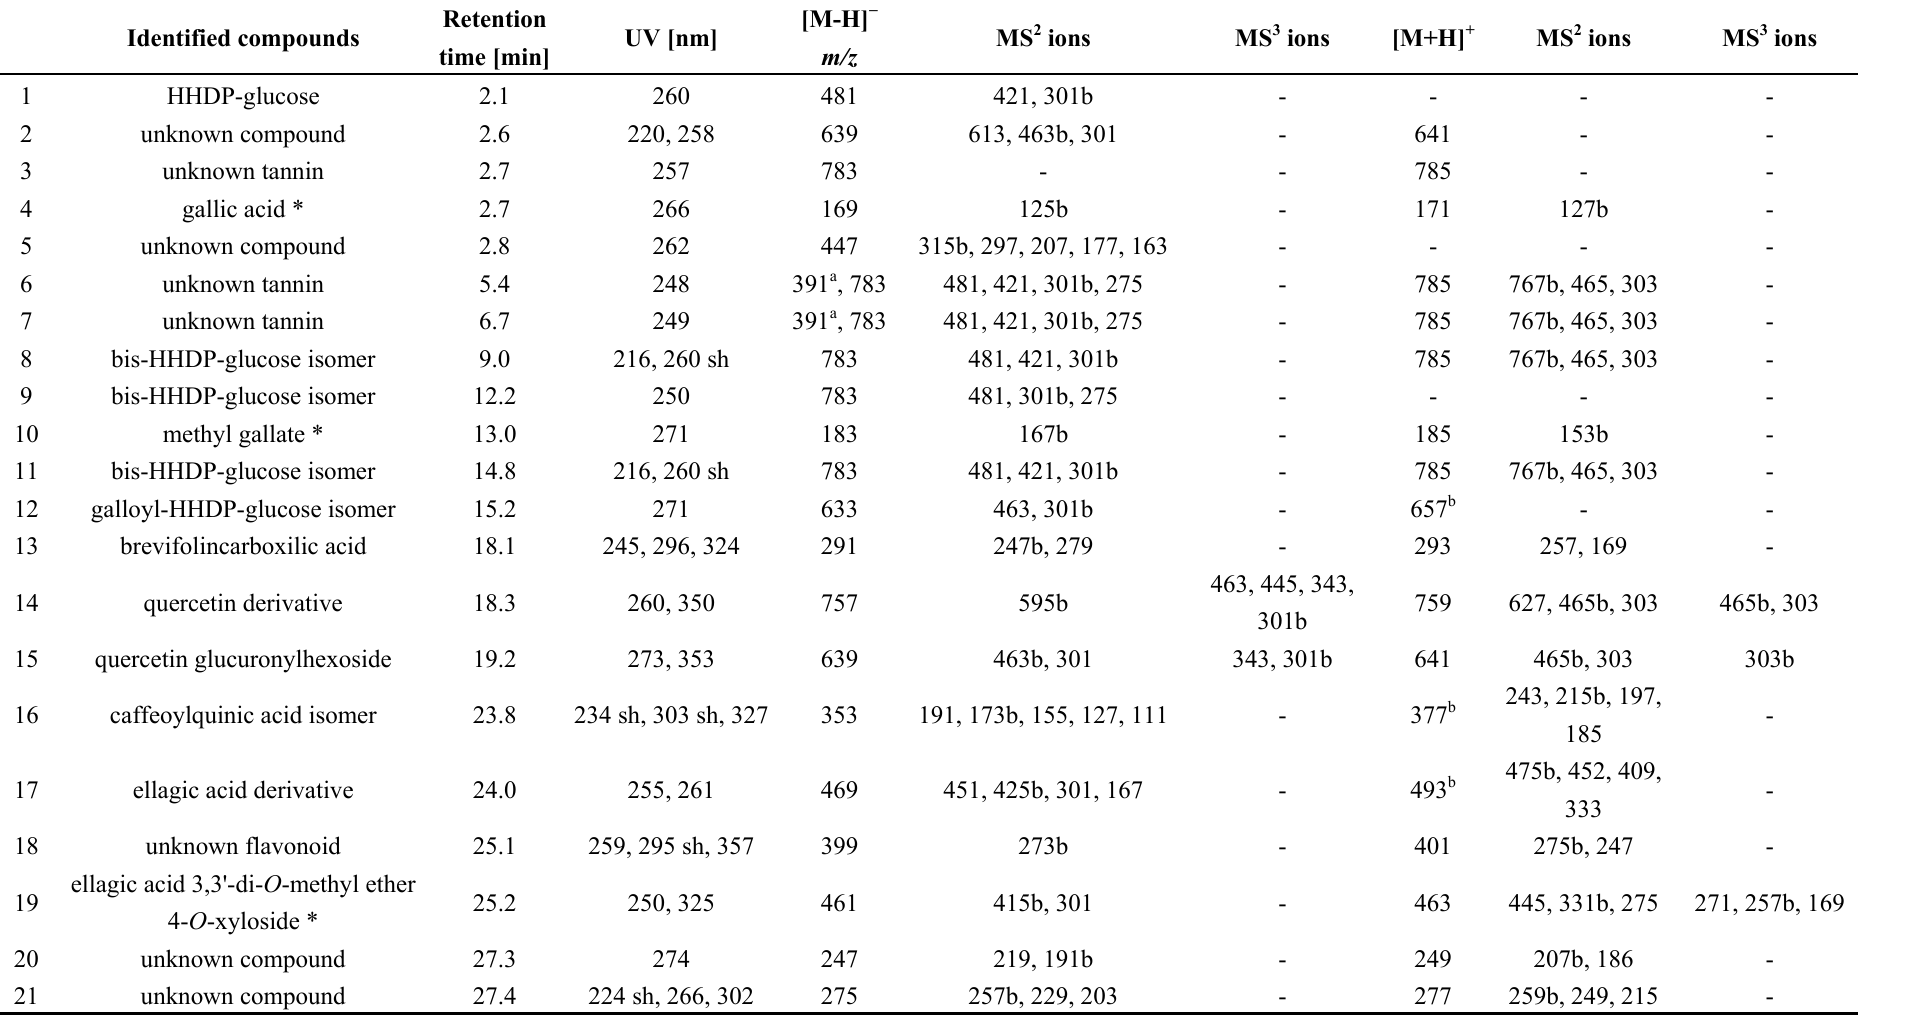
Table 3. HPLC-DAD-MS identification of compounds contained in D. rupestris